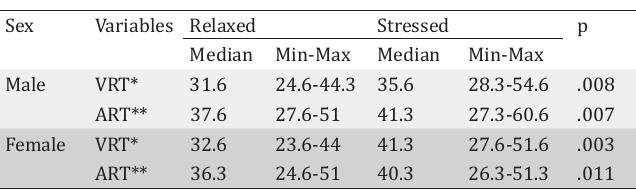
Median (Min-Max) values of VRT and ART measurements and Wilcoxon paired-samples test results between relaxed and stressed